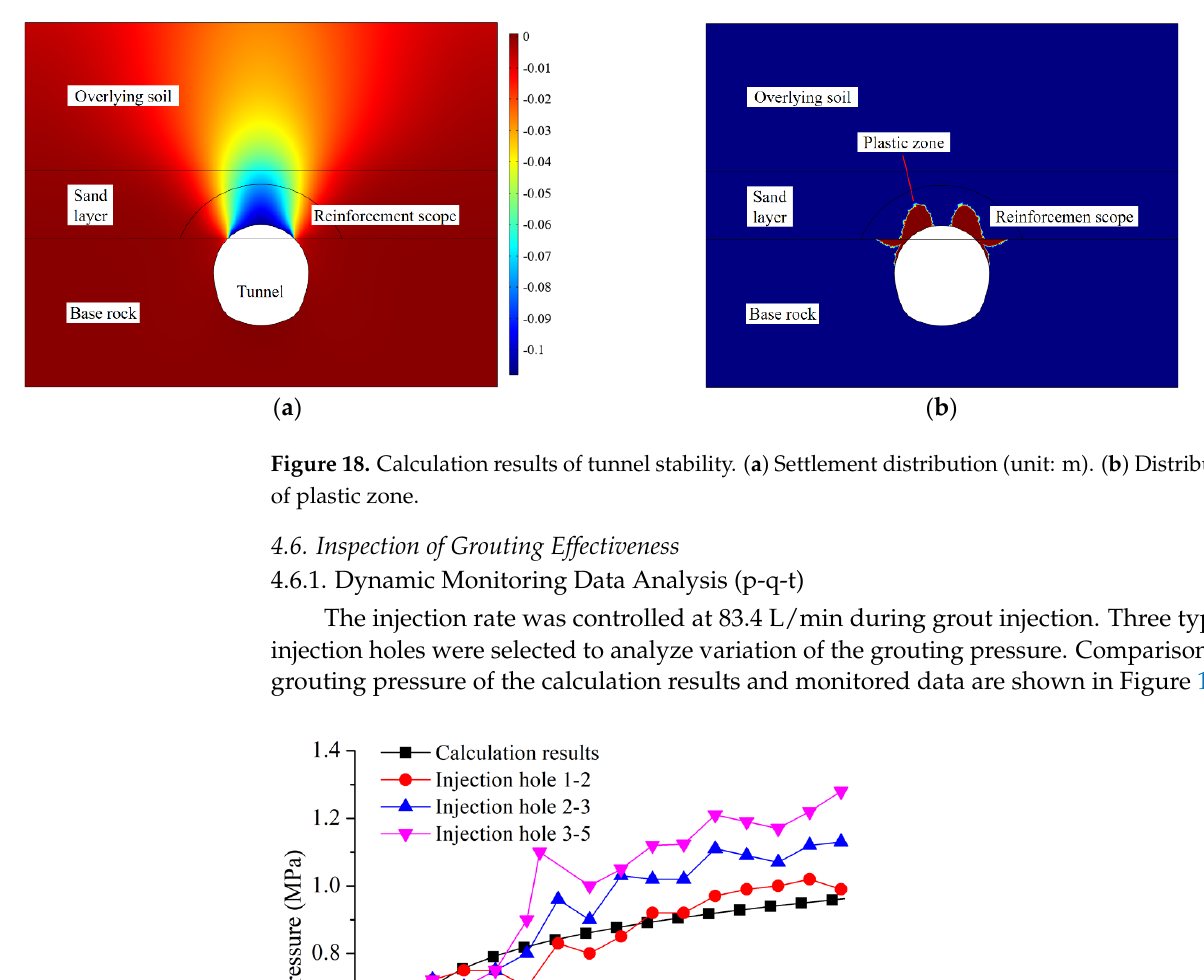
22 of 27 Figure 17. Calculation model. Calculation results of tunnel stability are shown in Figure 18. Vertical settlement of